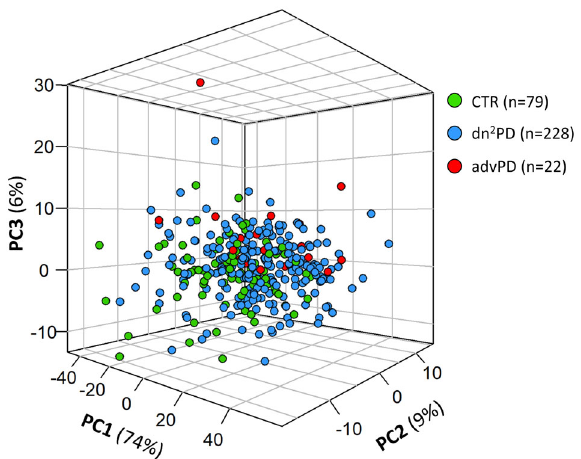
Table 2. Performances of the prediction models.